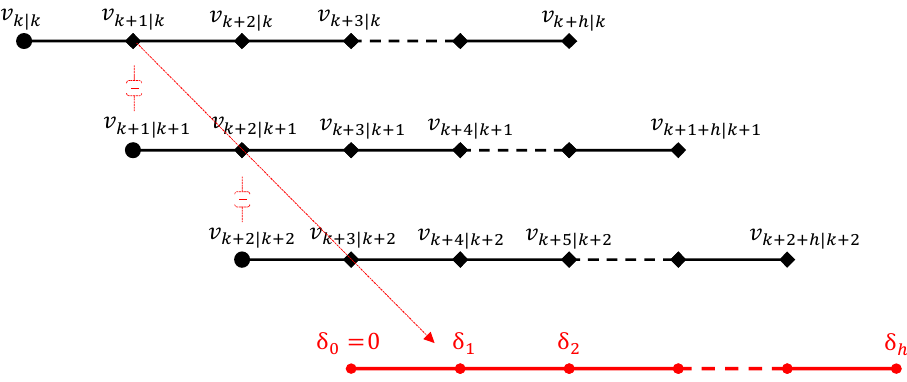
Figure 6. Illustration of the control deviation calculation